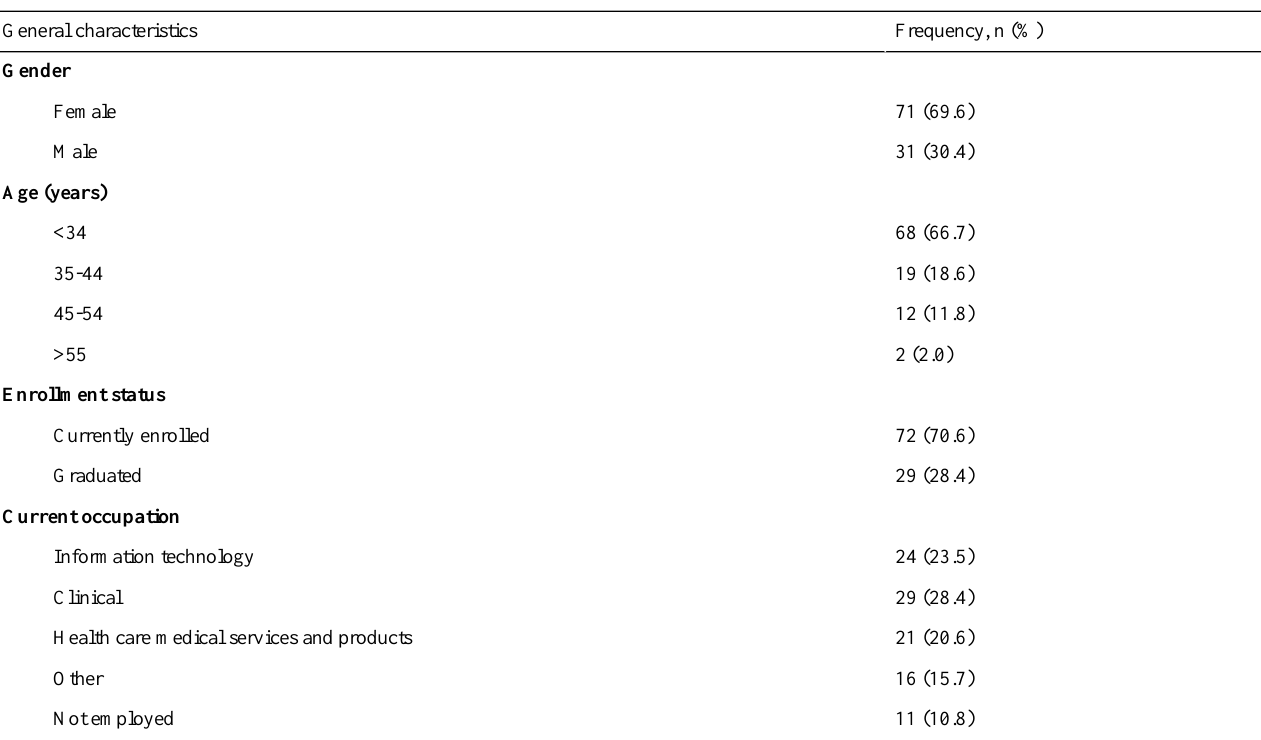
Table 3. Frequency and percentage of respondents classified by demographic details